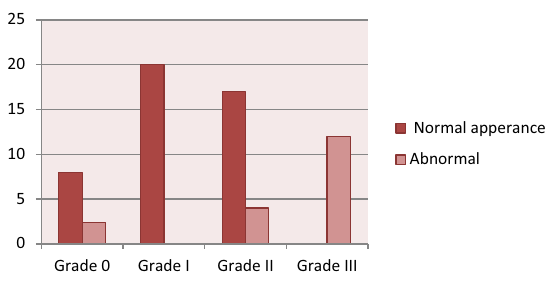
Fig. 5 Diagrammatic demonstration of the degree of cartilage degeneration and conventional MR appearance of the cartilage